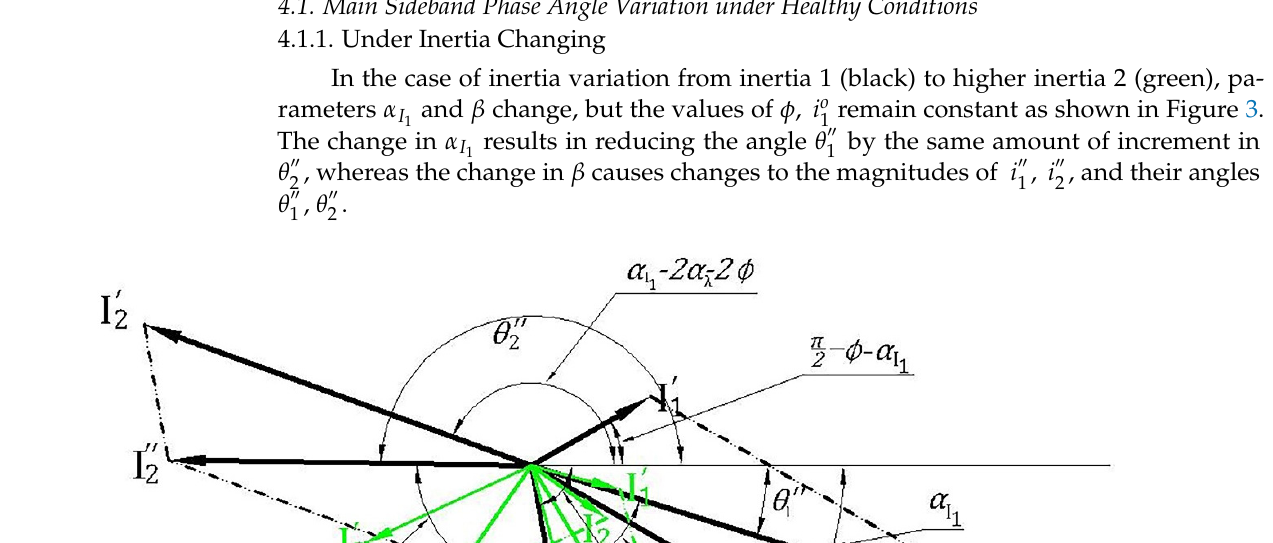
Figure 3. A phasor diagram representing the impact of inertia changes on 𝑖 (cid:2869)(cid:4593)(cid:4593) and 𝑖 (cid:2870)(cid:4593)(cid:4593) current compo- nents under healthy conditions.